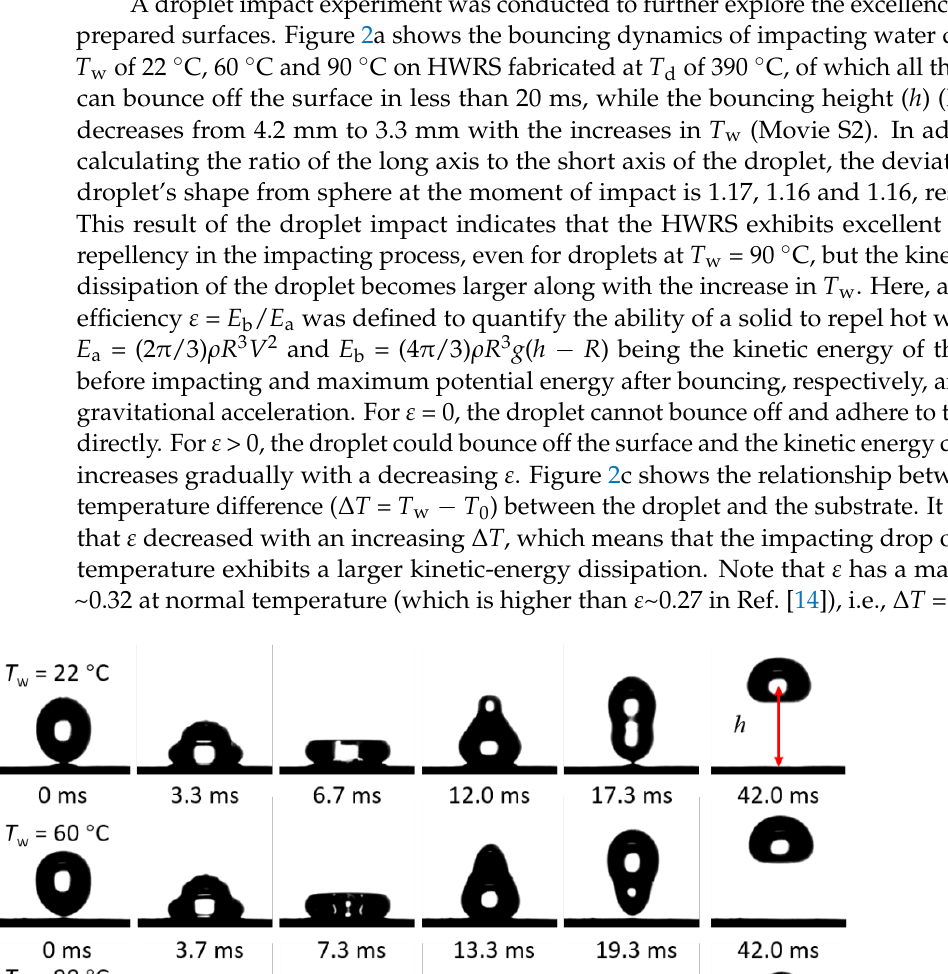
Figure 2. Hot-water droplets impacting on HWRS. ( a ) Snapshots showing droplets of 22 °C, 60 °C and 90 °C, respectively, impacting on the HWRS; ( b ) schematic of a hot-water droplet impacting on HWRS; ( c ) bouncing efficiency ε as a function of temperature difference Δ T = T w − T 0 between the droplet and the substrate. 4. Discussion 4.1. Mechanism of Kinetic-Energy Dissipation during Droplet Impact To explore the mechanism of kinetic-energy dissipation in the impacting process, we analyzed the growth kinetics of the liquid bridge in the solid – liquid contact area based on the theory reported by David et al. [14,26]. When impacting on a cold superhydrophobic surface, hot water generates condensation within the cavities of surface textures, which might lead to generating a liquid bridge to connect and stick the droplet to the substrate. Note that the generation of a liquid bridge is determined by the gas condensation time ( t 1 ) and solid – liquid contact time ( t 2 ), which can be evaluated as t 1 ~ ρh s2 / D ∆ C sat and t 2 ~ ( ρ R 3 / γ ) 0.5 , respectively [14]. The value of t 2 is on the order of 10 ms for millimetric droplets [14]. Here, h s is the height of surface structures, D is ~ 20 mm 2 /s is the diffusion coefficient of vapor in air, and ∆ C sat = C sat ( T w ) − C sat ( T 0 ) is the vapor-mass-concentration difference at temperatures of T w and T 0 . When t 1 is larger than t 2 , the condensed tiny droplets are smaller than the structure height h s , and thus no liquid bridge generated to link the sub- strate and water droplet. For the opposite condition that t 1 is smaller than t 2 , liquid bridges generate to connect the droplet to the substrate, during which the adhesion force ( F ) can be expressed as F ≈ 4π R m γN , where R m is the maximum radius of solid – liquid interface and N is the probability of having a water nucleus in a cell. The energy ( E adh ) induced by the adhesion F on the radius R m yields E adh = 2 π γR m2 N . Since the viscous dissipation gen- erated during the impact is much smaller than E a , we ignore its effect [27]. For E a > E adh , the droplet will bounce off the surface and E adh is equal to the kinetic-energy dissipation